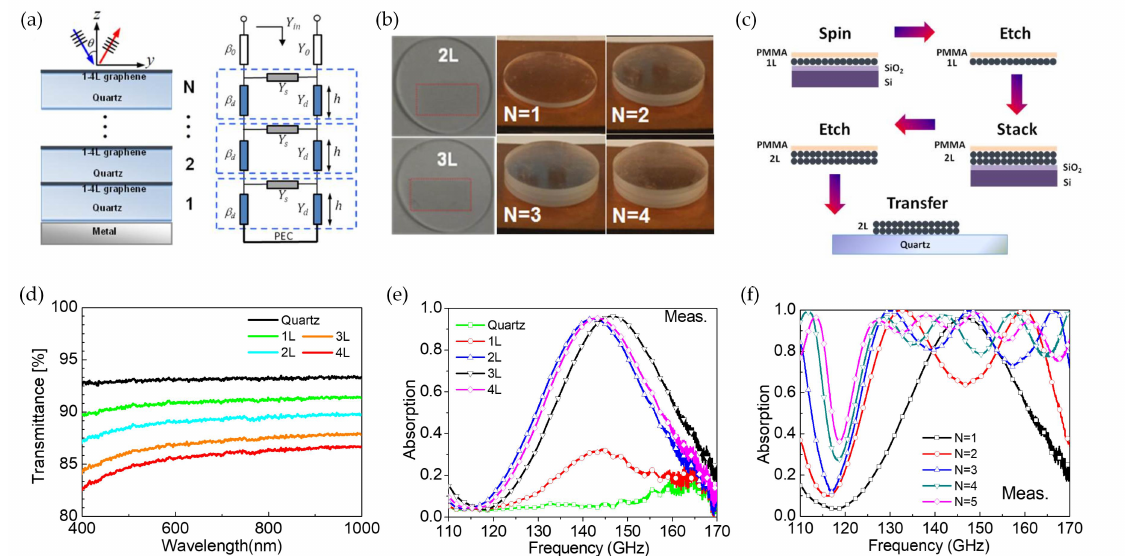
Figure 1. ( a ) schematic of a N -unit Jaumann absorber and the corresponding transmission-line model; ( b ) images of graphene–quartz samples with bilayer (2 L) and trilayer (3 L) graphene as well as one to four stacked samples over the metallic ground; ( c ) fabrication procedure of a 2 L graphene–quartz sample; ( d ) UV-Vis spectra of the bare quartz and 1 L–4 L graphene–quartz samples; ( e ) measured absorption spectra of graphene Salisbury screens with bare quartz and 1 L–4 L graphene–quartz samples; ( f ) measured absorption spectra of graphene Jaumann absorbers with N = 1–5; reprinted with permission from Ref.